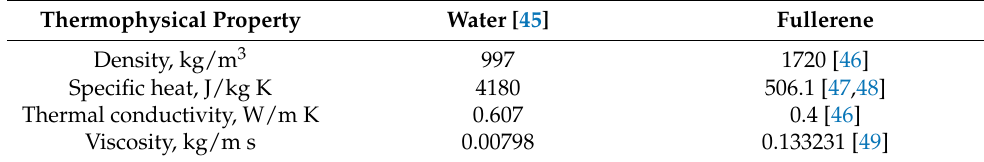
Table 1. Thermophysical properties of water and nanoparticles at 300 K.